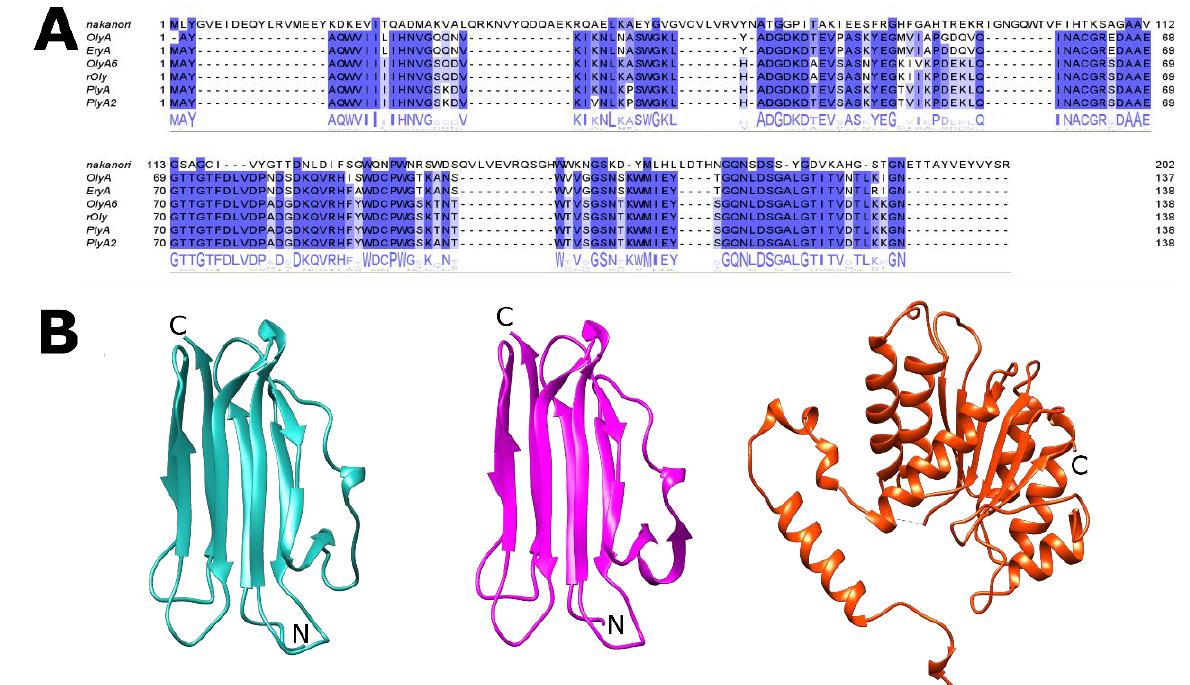
Figure 1. Fungal lipid raft binding proteins. ( A ) Jalview representations of amino acid sequence alignment of the aegerolysin proteins: ostreolysin A (OlyA; NCBI AAX21097.1); ostreolysin A6 (OlyA6; UniProtKB/Swiss-Prot: P83467.2); recombinant ostreolysin (rOly; NCBI KDQ25828.1); pleurotolysin A (PlyA; NCBI BAD66666) from Pleurotus ostreatus ; pleurotolysin A2 (PlyA2; NCBI BAN83906.1) from Pleurotus eryngii , and nakanori (NCBI BAO31550.1) from Griofola fondosa . Positions of the highest similarity are shaded in blue. ( B ) Representative aegerolysin crystal structures of OlyA6 (pink; PDB 6MYI), PlyA (green; PDB 4OEB) and nakanori (orange; PDB 5H0Q), visualised using the UCSF (University of Californiaa, San Francisco). Chimera package. The N-termini and C-termini are indicated.